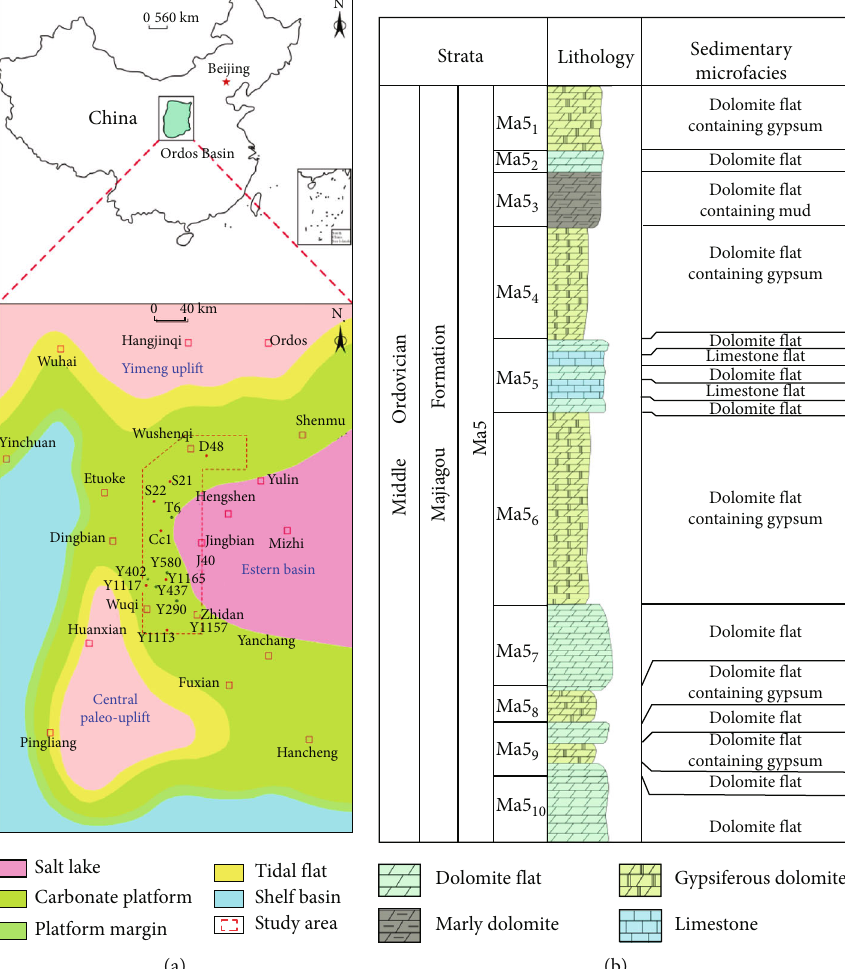
Figure 1: (a) Sedimentary environment of the fi fth member of the Majiagou Formation in the Ordos Basin and location of the study area (after [46]); (b) comprehensive stratigraphic column of Member